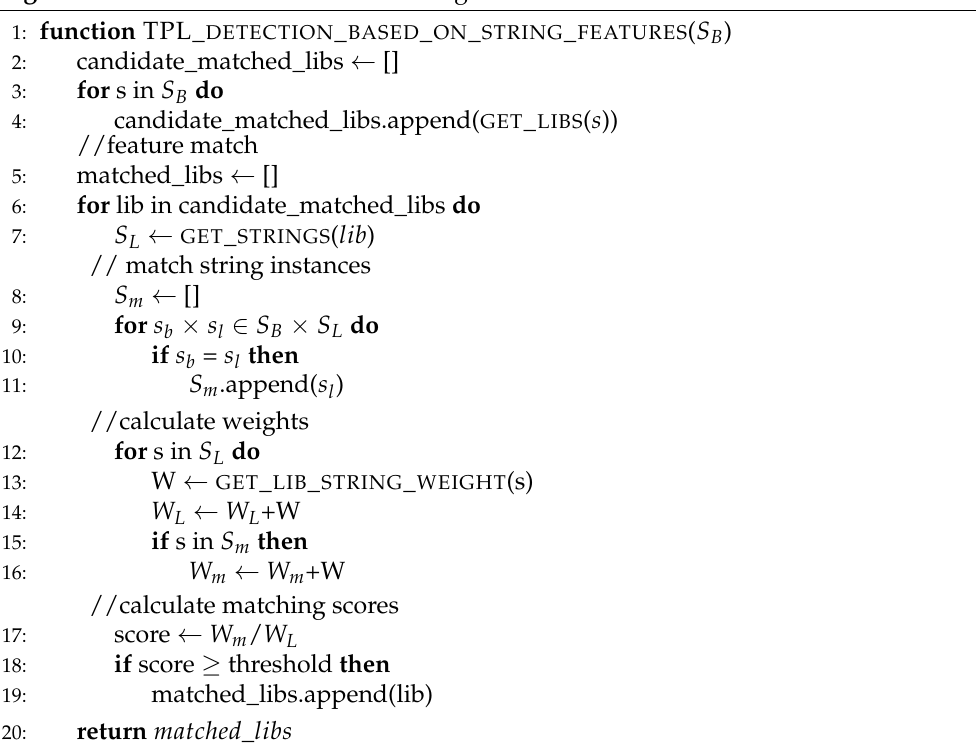
Algorithm 1 TPL detection based on string